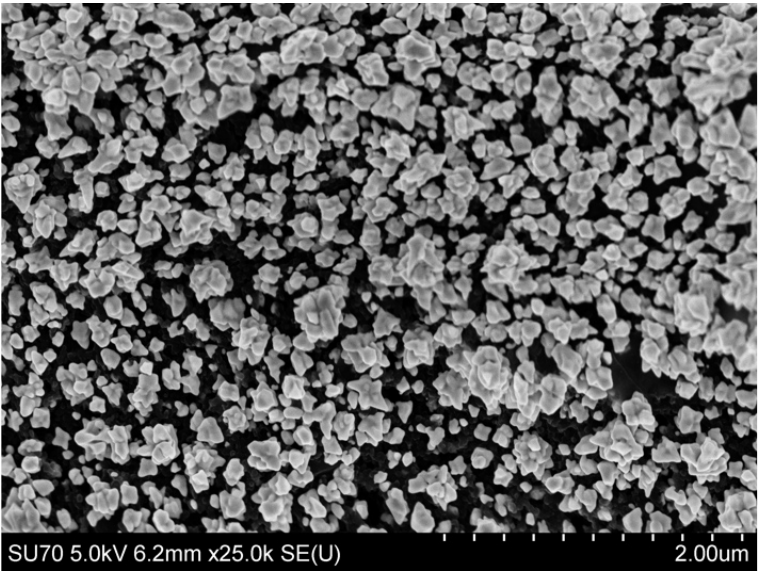
Figure 6. SEM micrograph of SPCE/AuNS.